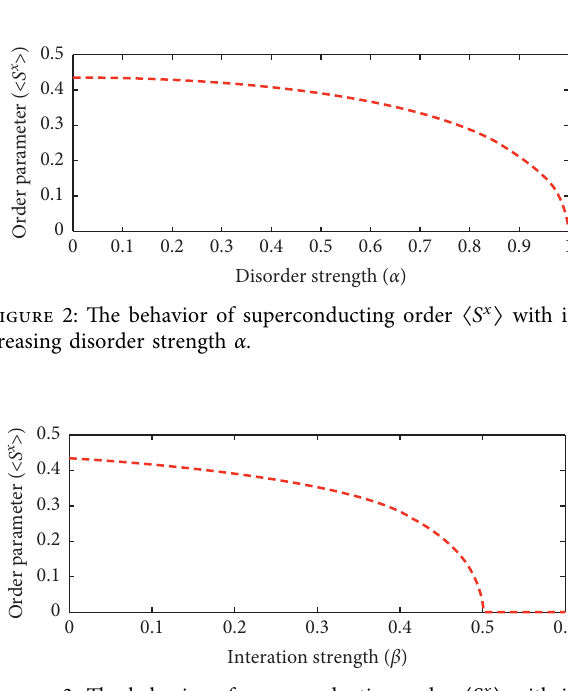
Figure 1: Superconducting islands separated by insulating regions (a). For very thin films, the islands are assumed to be on lattice sites (b) [21].